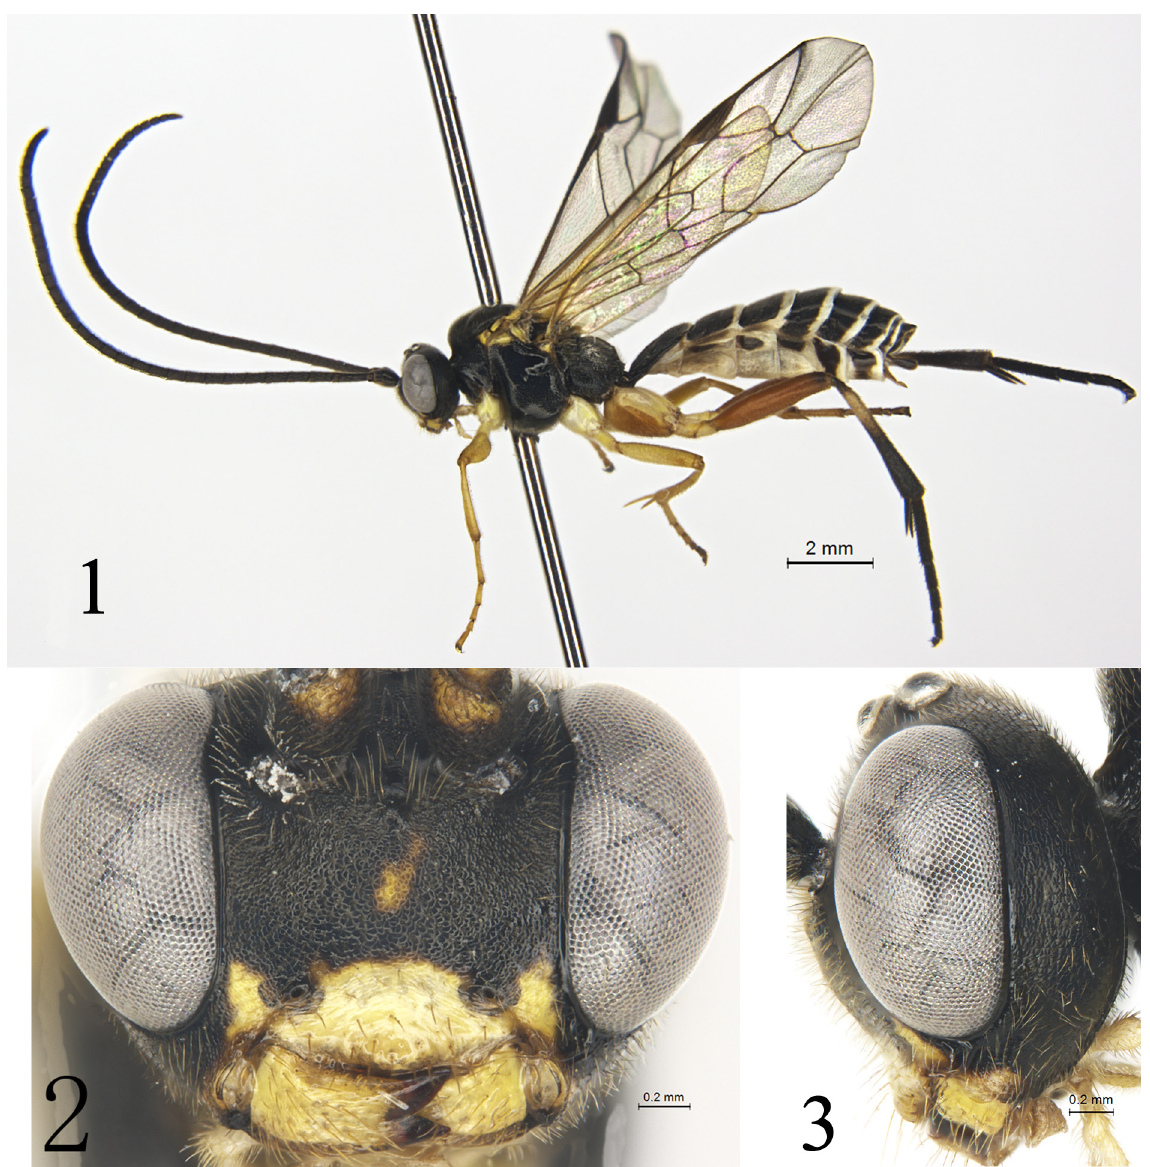
Figs 1–3. Campodorus albilineatus Sheng, Sun & Li sp. nov., holotype, ♀ (GSFGPM). 1 . Habitus, lateral view. 2 . Head, anterior view. 3 . Head, lateral